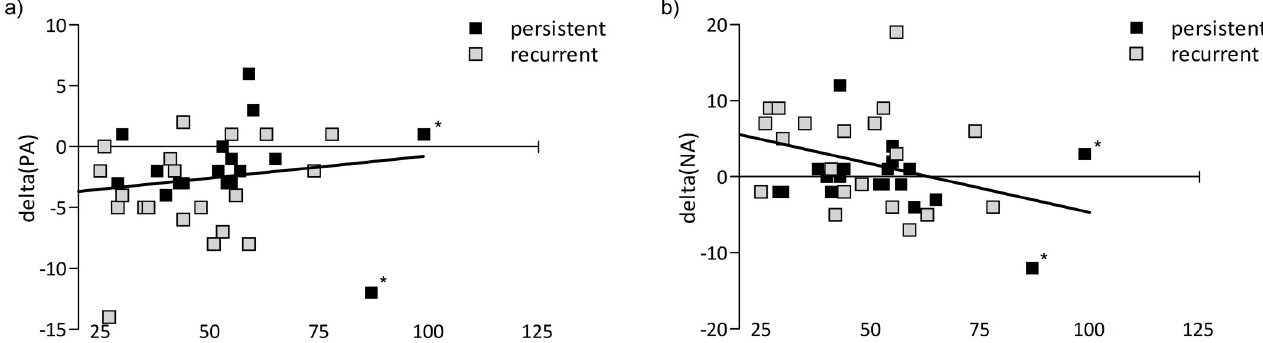
Fig 3. Scatterplots for the relationships between changes in positive affect ( Δ PA, a) and negative affect ( Δ NA, b) on the y-axis with CTQ score (min = 25, max = 125) on the x-axis. The analyses were performed on the combined group of persistent and recurrent patients, since CTQ scores did not differ between groups. For illustration purposes, the two groups are depicted in different colors. persistent = patients with persistent depression, recurrent = patients with recurrent depression. Asterisks denote outliers according to the interquartile-range method.